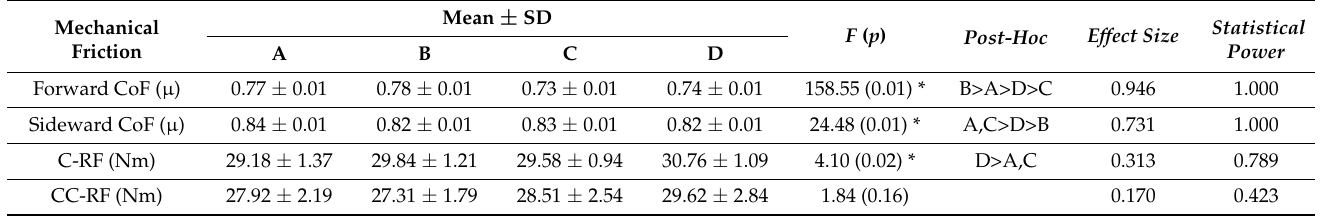
Table 1. Frictional force by direction depending on the outsole pattern upon mechanical test.